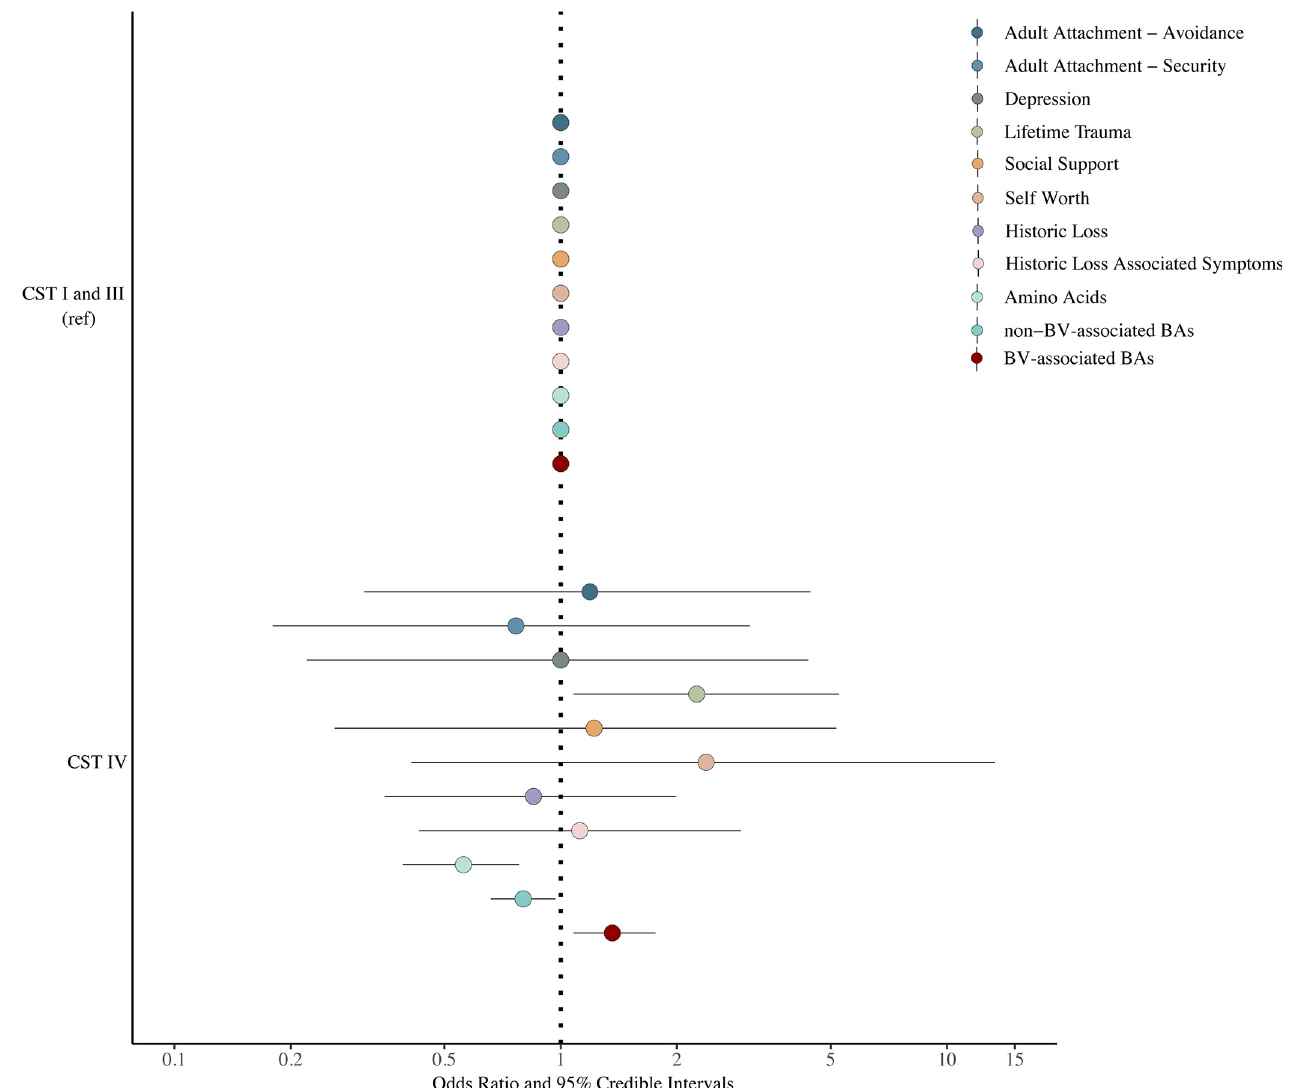
Fig 3. Adjusted odds ratio for CST by measures of psychosocial stress. Circles represent point estimates while bars indicate 95% credible intervals. Odds ratios were adjusted for smoking